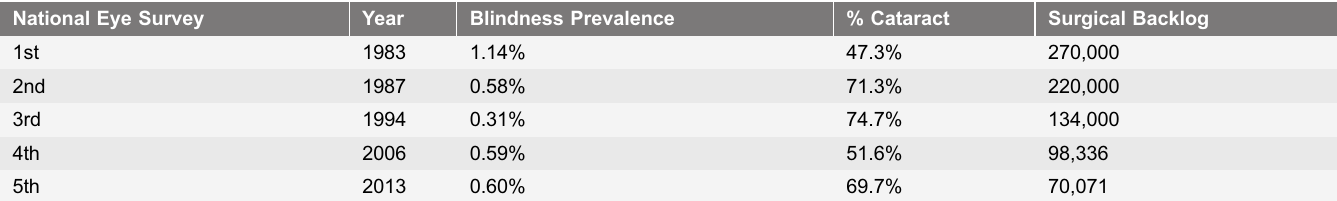
Table 8. Comparison among five National Eye Surveys in